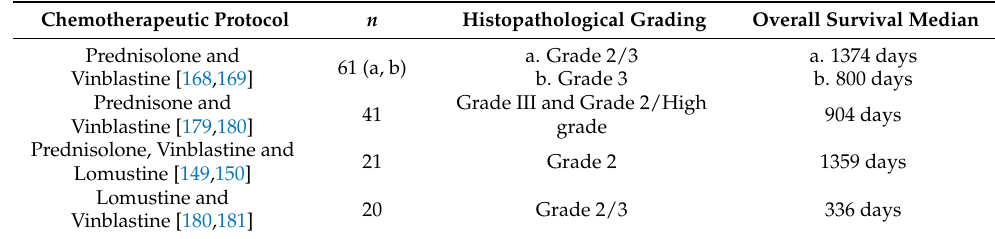
Table 5. Chemotherapy Protocols Evaluated in Canine Mast Cell Tumors and Mean Overall Survival.